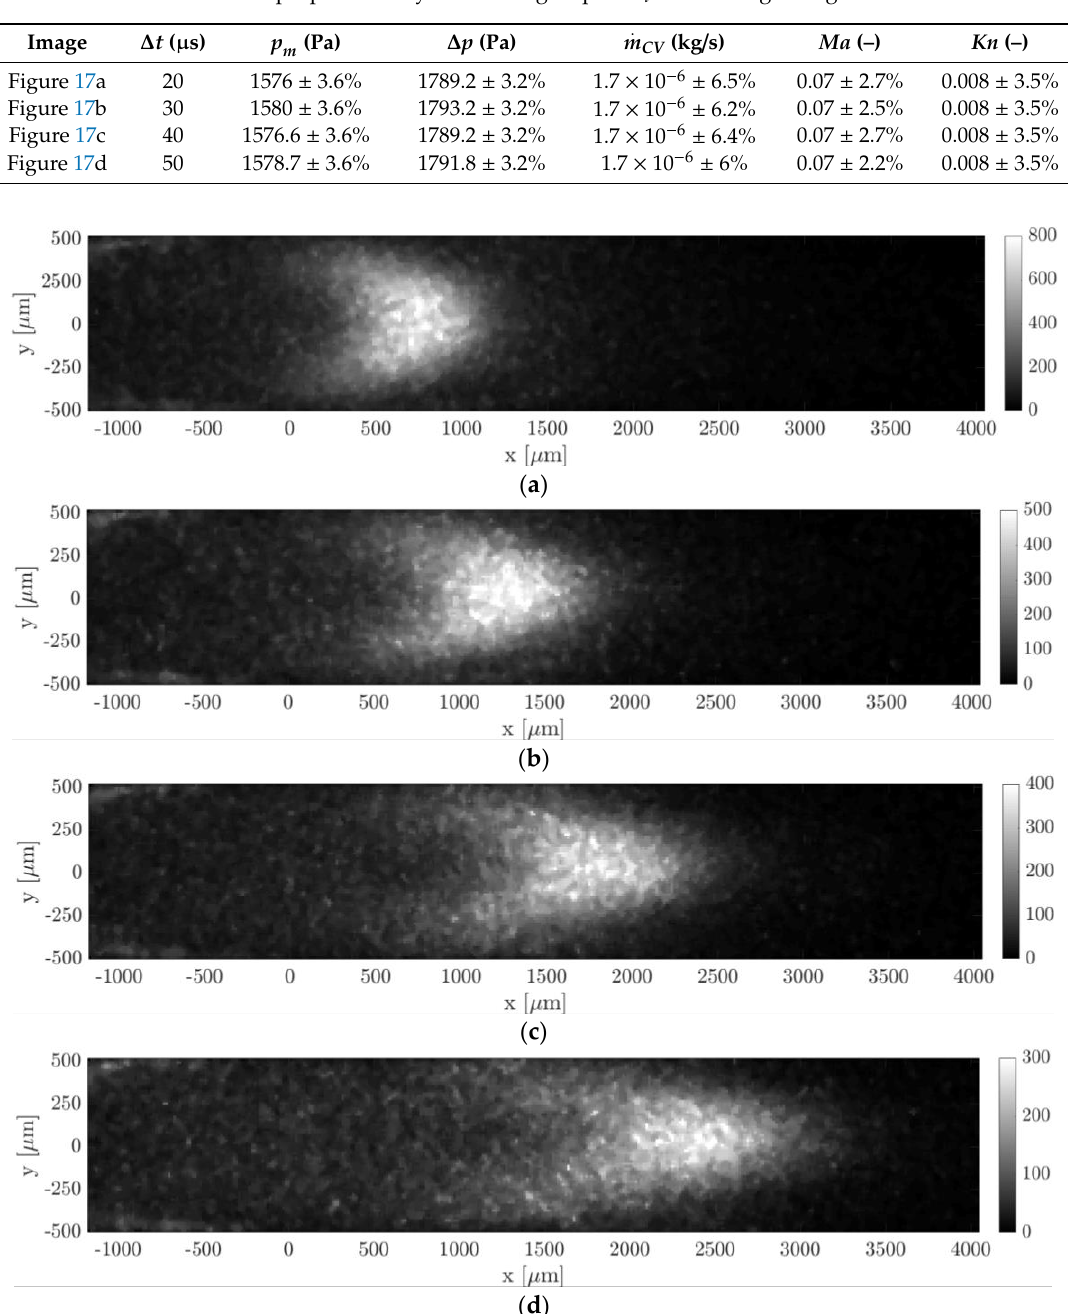
Table 3. Flow properties associated to the images of Figure 17. The reported percentage change indicates how much the properties vary inside the group of 𝑁 𝑖 = 20 average images.